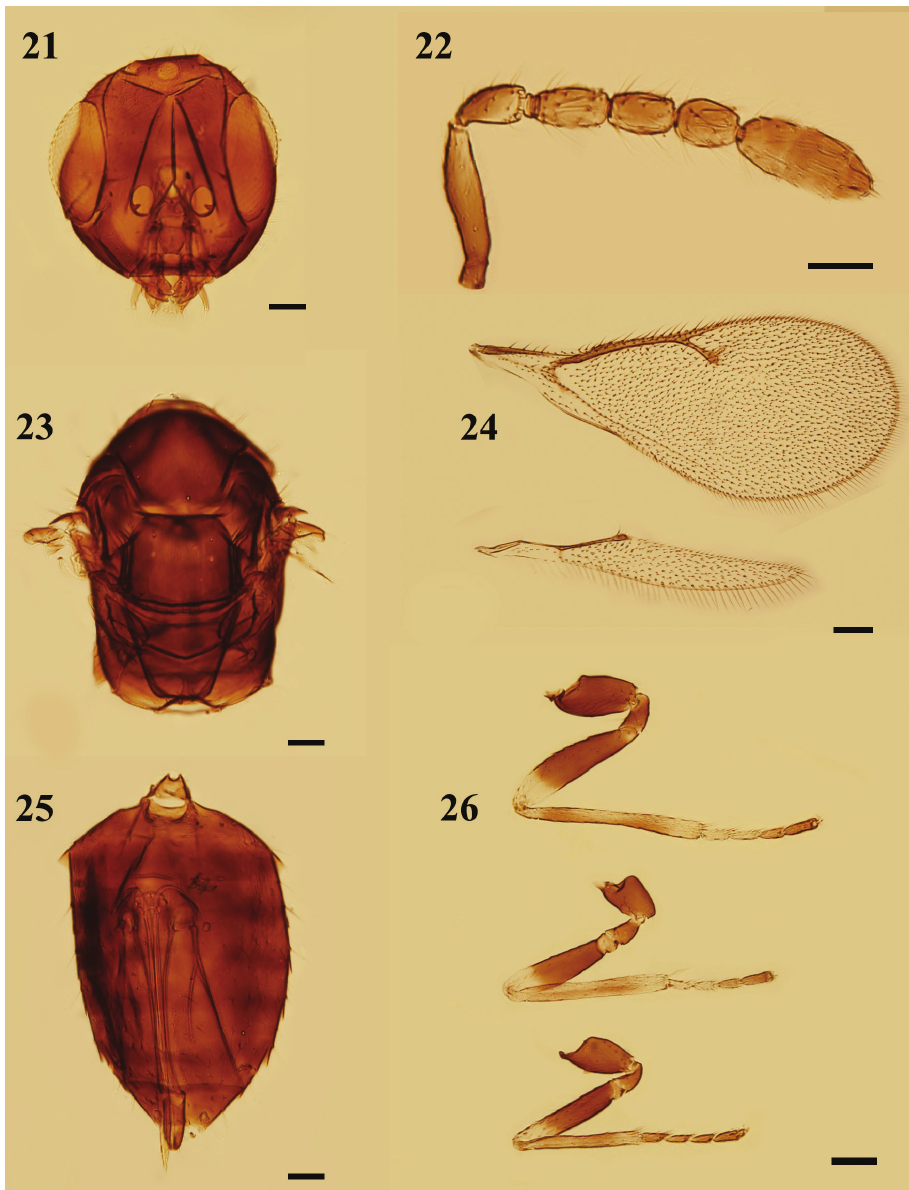
23 mesosoma, dorsal view 24 fore and hind wings, dorsal view 25 metasoma, ventral view 26 legs, lateral view, from bottom to top: fore, mid, and hind legs. Scale bars: 100